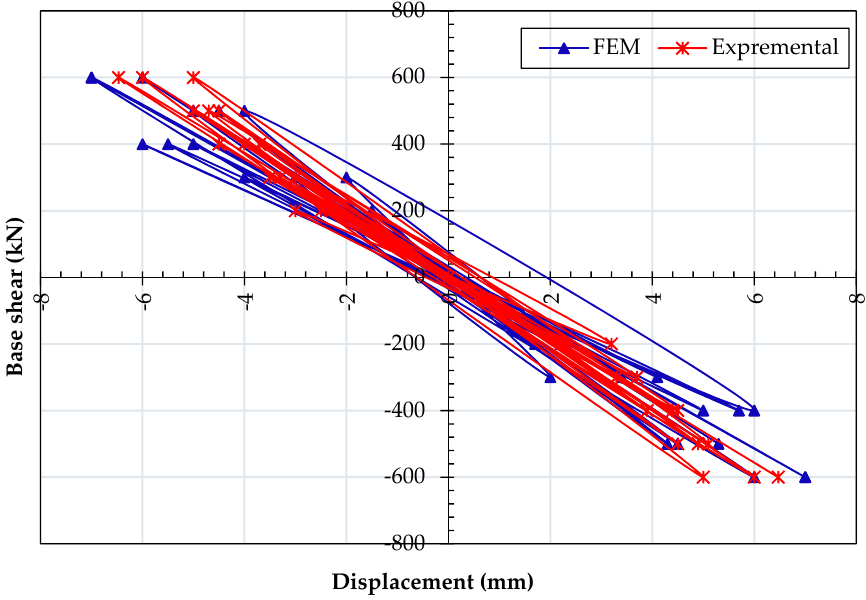
Figure 5. Comparison of deformation load in the numerical and experimental model for CSPSW. In the test loading process, the steel plate experienced severe buckling at different positions with increasing horizontal displacement as shown in Figure 6. The FE model could simulate the local buckling phenomenon, as shown in Figure 7.